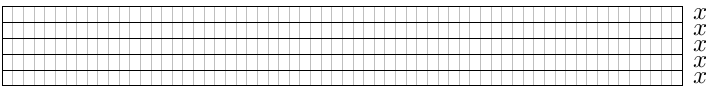
Figure 1: The Ascon state of 320 = 5 × 64